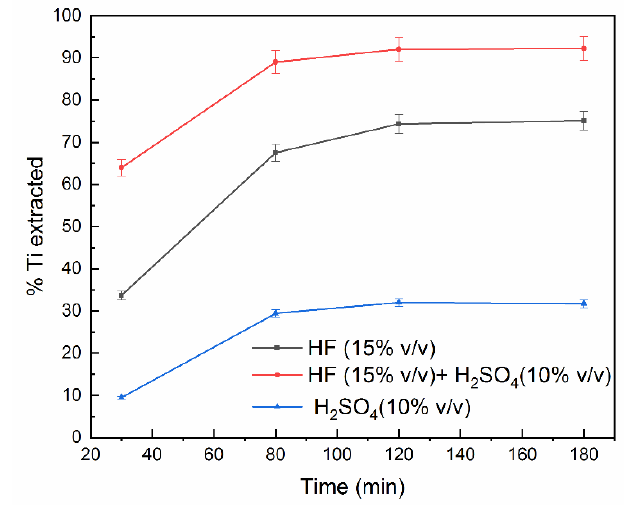
ff ect of leaching Figure 5. Effect of leaching time. Figure 5. E